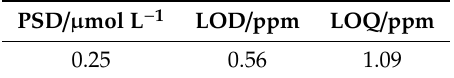
Table 1. Values for process standard deviation (PSD), limit of detection (LOD) and limit of quantitation (LOQ); referring to Figure 1; according to DIN